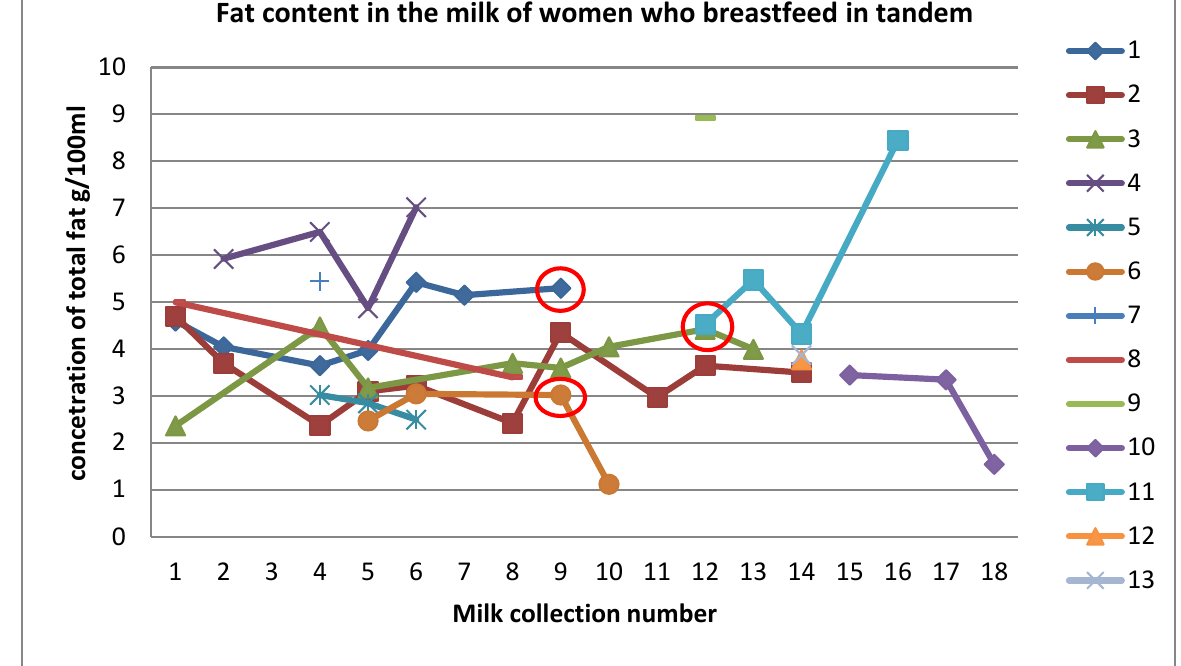
Chart 1. Individual changes in total fat content. The weaning time is indicated by red circle, 1–10 monthly milk collection.